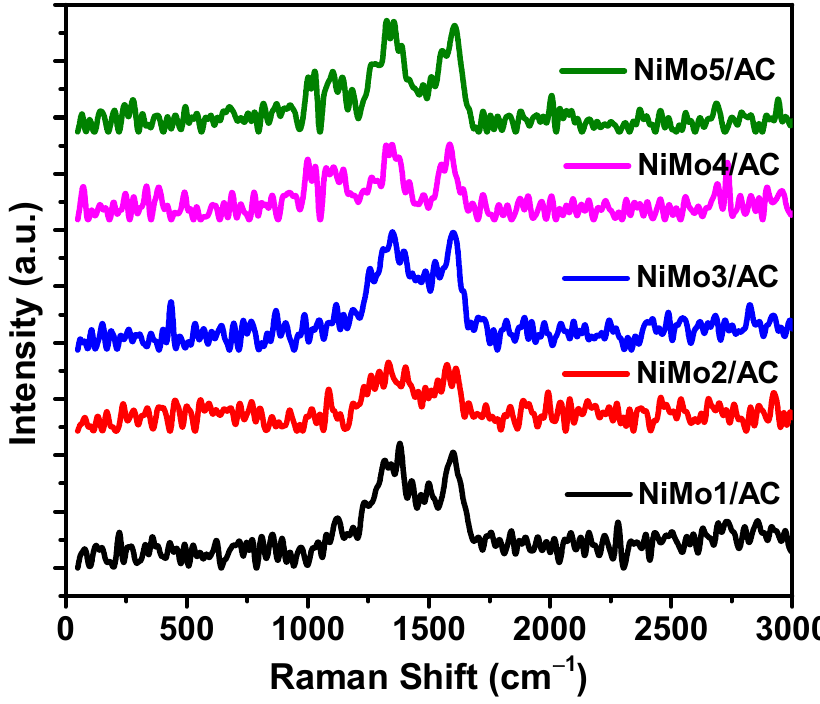
Figure 8 . Raman analysis of the prepared samples. Figure 8. Raman analysis of the prepared